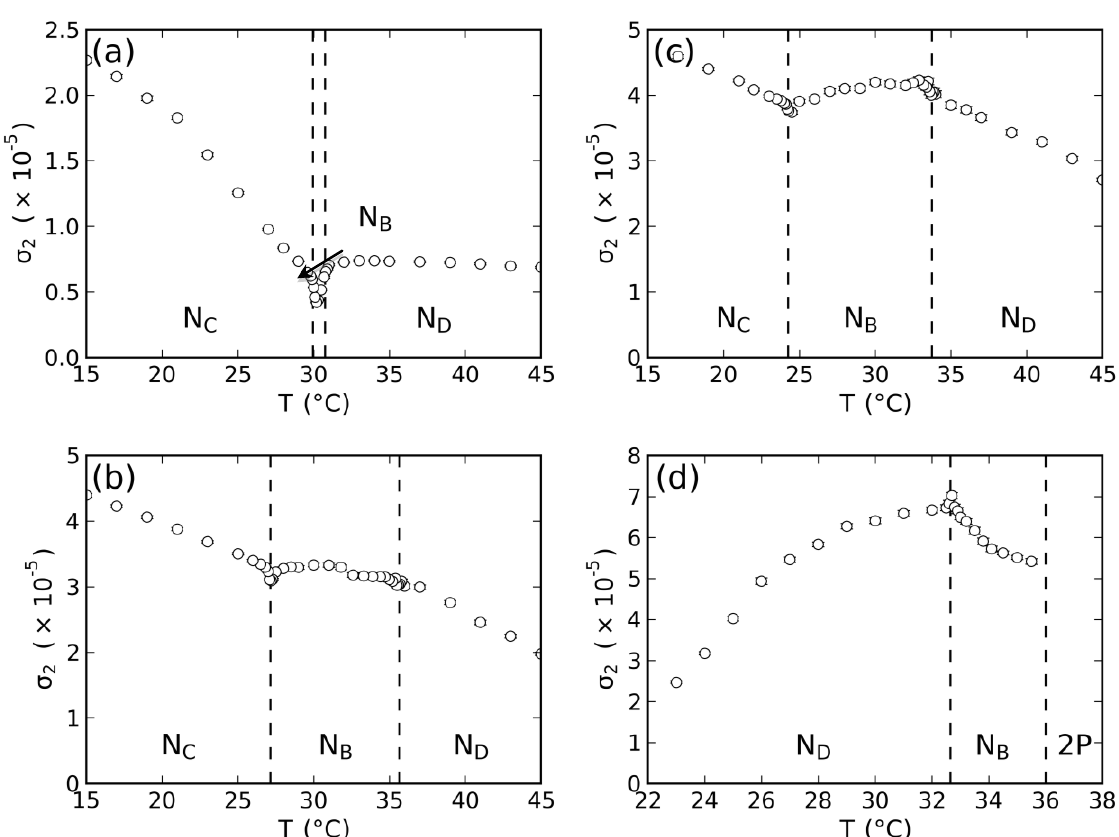
, of 2 SO /UndeOH/water; 2 4 SO 2 4